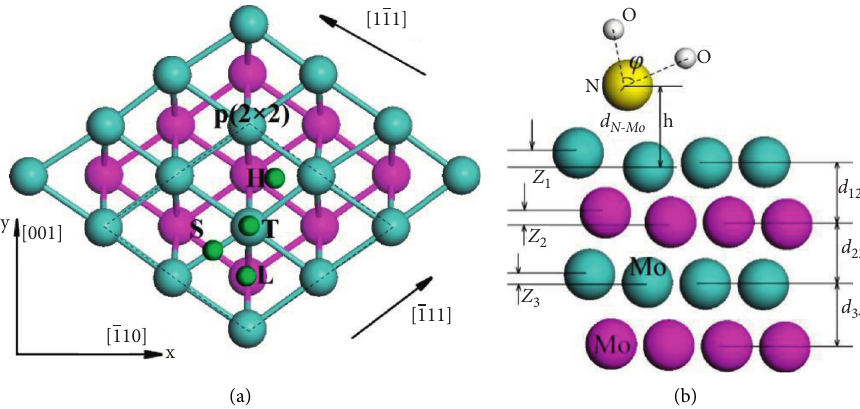
Figure 1: Model of Mo (110) surface (a) schematic diagram of possible adsorption coordination (b) schematic diagram of relaxation and other parameters.